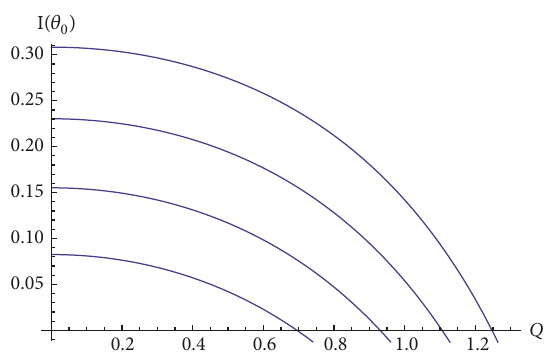
Figure 3: Relation between 𝐼(𝜃 0 ) and 𝑄 . Curves from top to down represent 𝑟 𝑚𝑖𝑛 increases from 1.42 to 1.48 with step 0.02. For both cases, we have set 𝑟 ℎ =1.